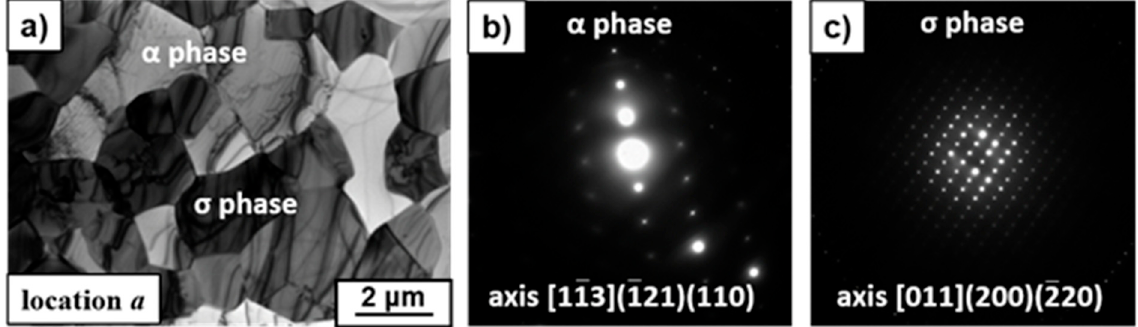
Figure 2. TEM image of the microstructure ( a ) and diffraction patterns of the α -phase ( b ) and the σ - phase ( c ), observed at the surface of the sample deformed at 800 °C.